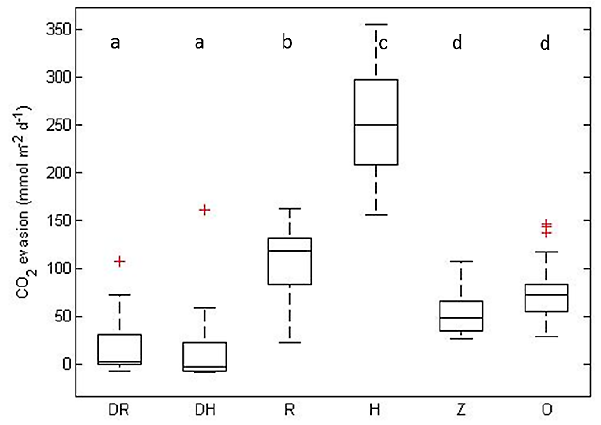
Fig. 3. Boxplots describing the CO 2 evasion (mmol − 2 d − 1 ) from the streams Rappbode (R, n = 52), Hassel (H, n = 53), Zillierbach (Z, n = 59) and Ochsenbach (O, n = 47) and the pre-dams Rapp- bode (DR, n = 14) and Hassel (DH, n = 14). The letters a, b, c and d indicate the significance of differences between groups ( p < 0 . 05).